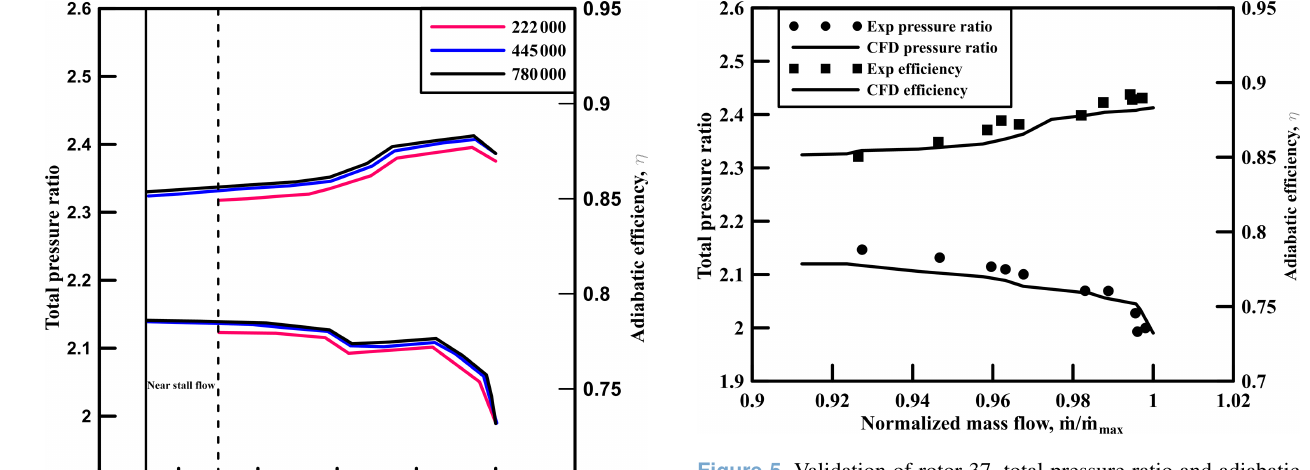
Figure 5. Validation of rotor 37, total pressure ratio and adiabatic